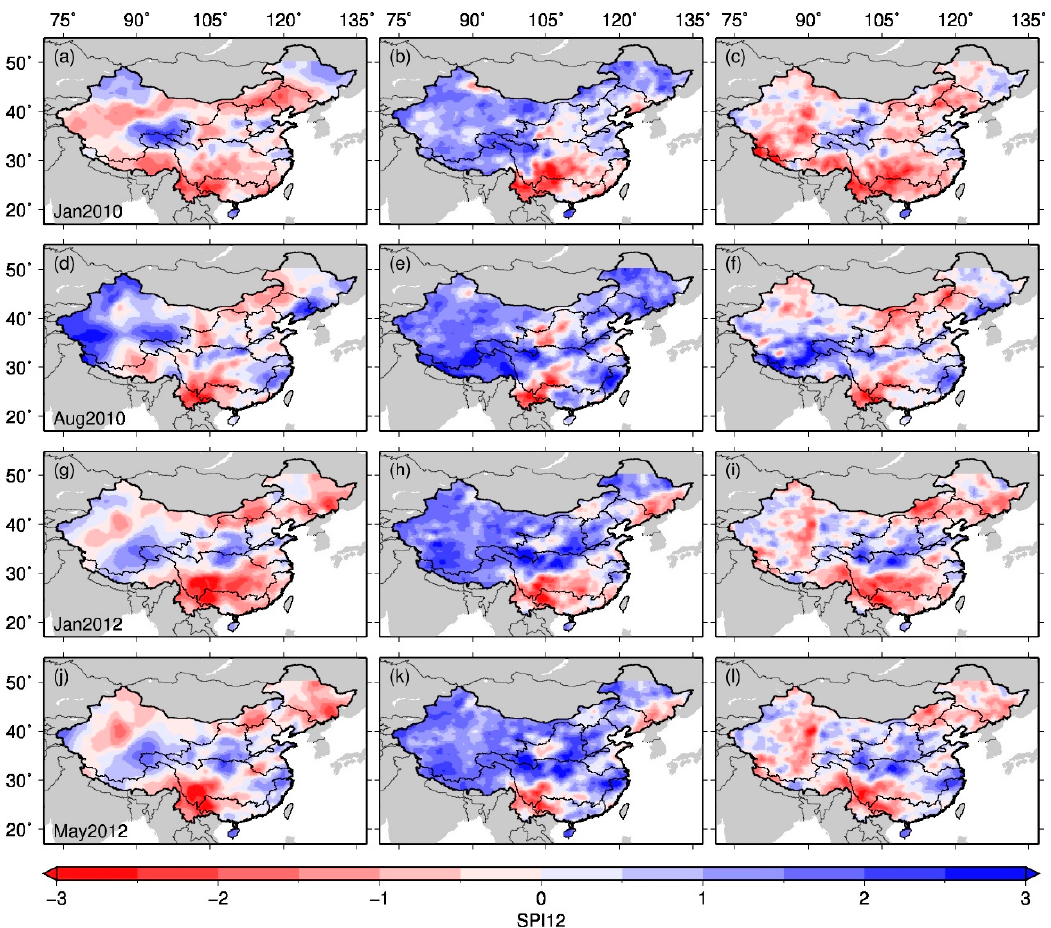
Figure 6. 12-month SPI (SPI12) derived from the gauge-based N05.1 data (left panels), 3B42RTV7–CN05.1 merged data (middle panels), and adjusted 3B42RTV7–CN05.1 merged data (right panels) for January ( a – c ) and August 2010 ( d – f ) and for January ( g – i ), and May 2012 ( j – l ).